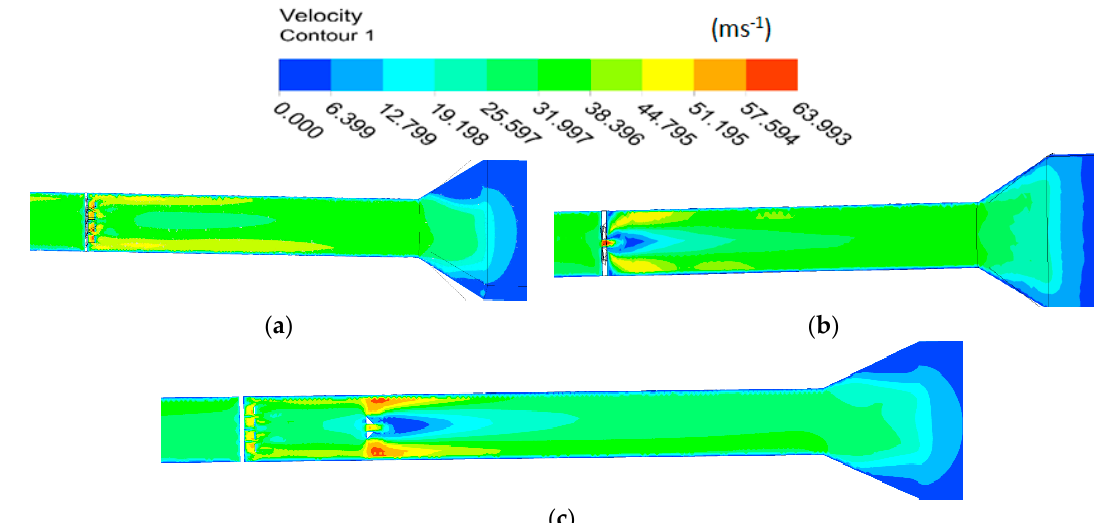
Figure 4. Velocity contour maps. ( a ) Line (LM) type mixer, ( b ) swirl (SM) type mixer, and ( c ) two mixers (LSM).